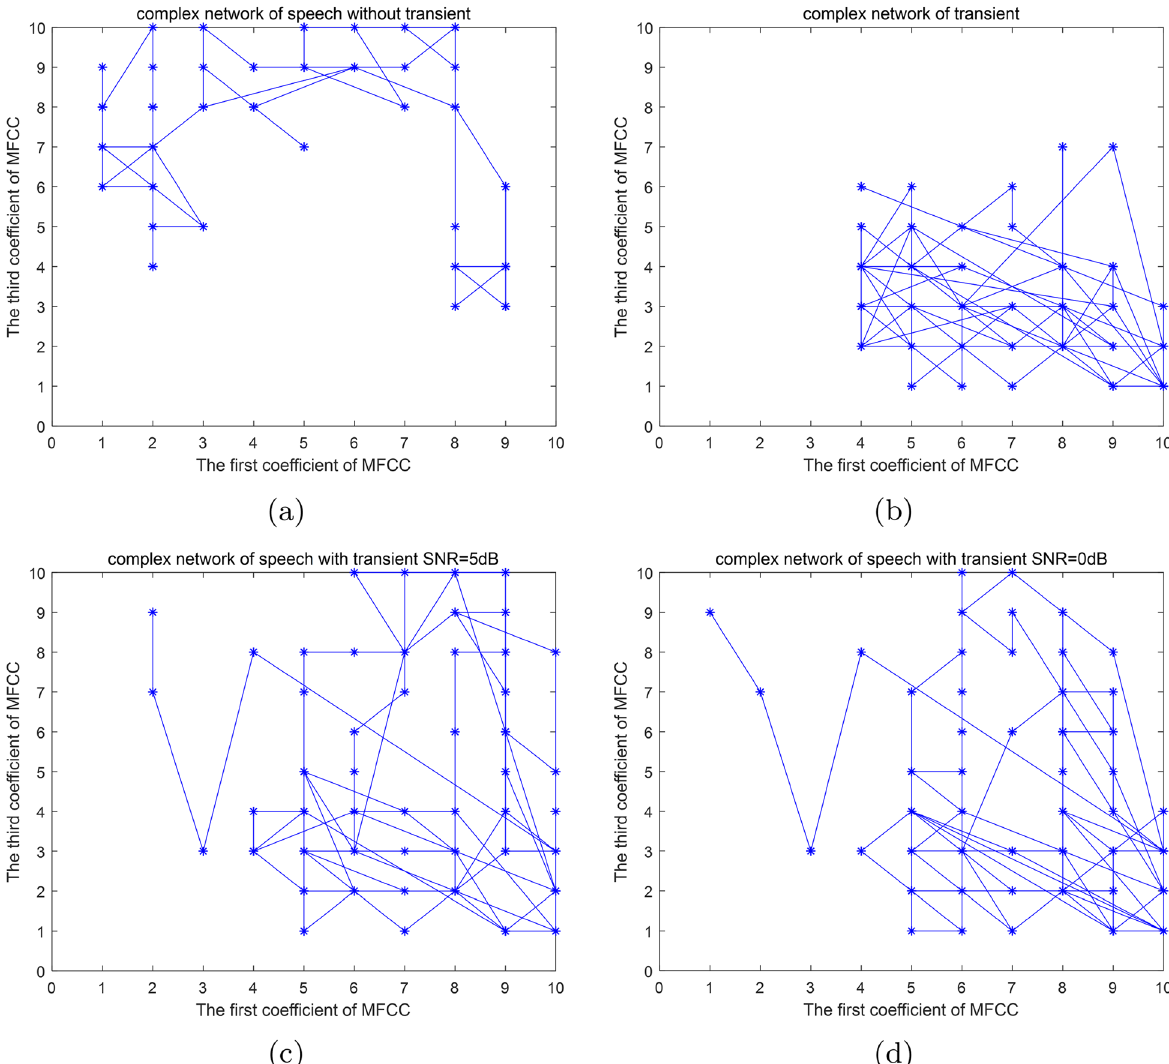
Fig. 5 The complex network of a speech without transient; b transient; c speech with transient, SNR Take the symbolized value of the first coefficient as X ‑axis and that of the third as Y